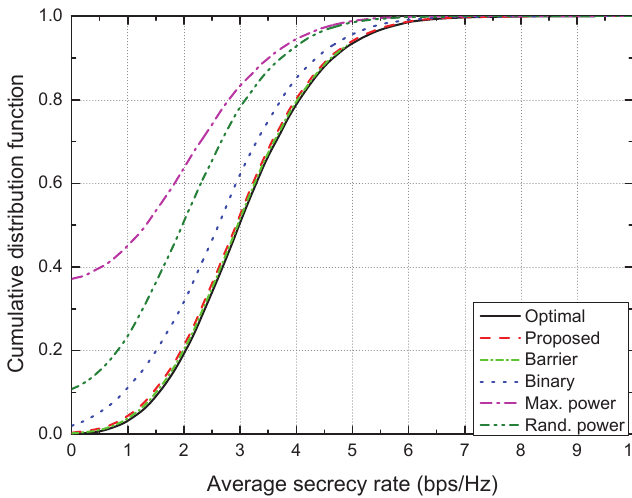
Figure 5. CDF vs. average secrecy